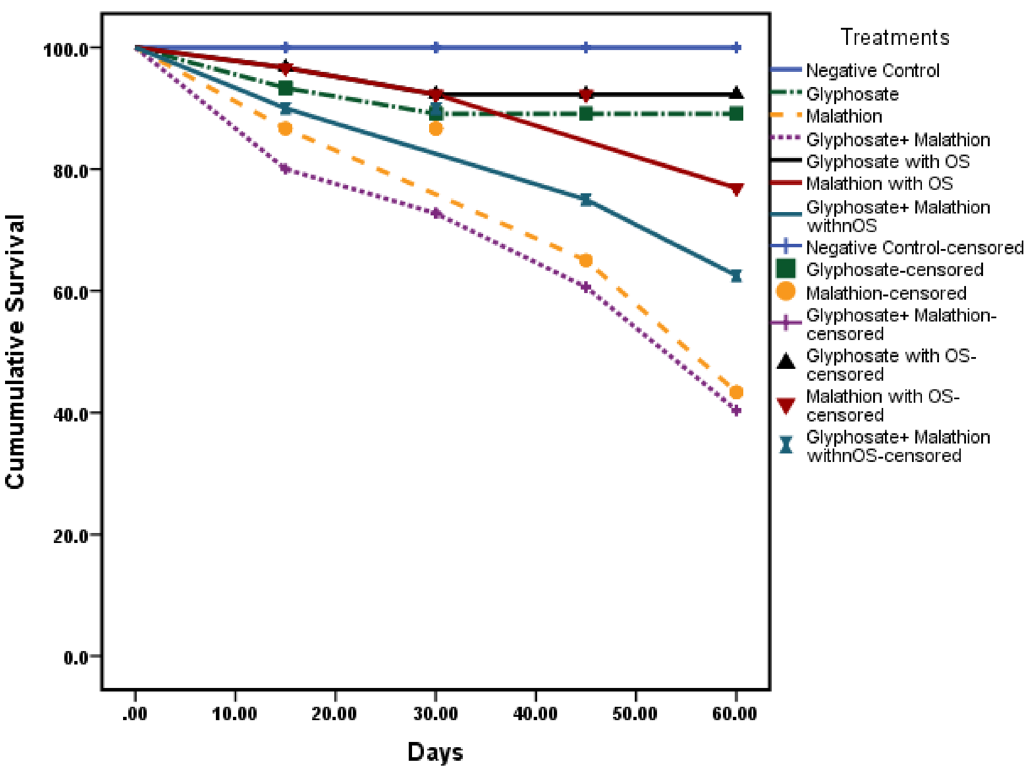
Figure 4. Cumulative survival rate for fish in all experimental groups exposed to glyphosate and or malathion intoxication in absent and presence of organic